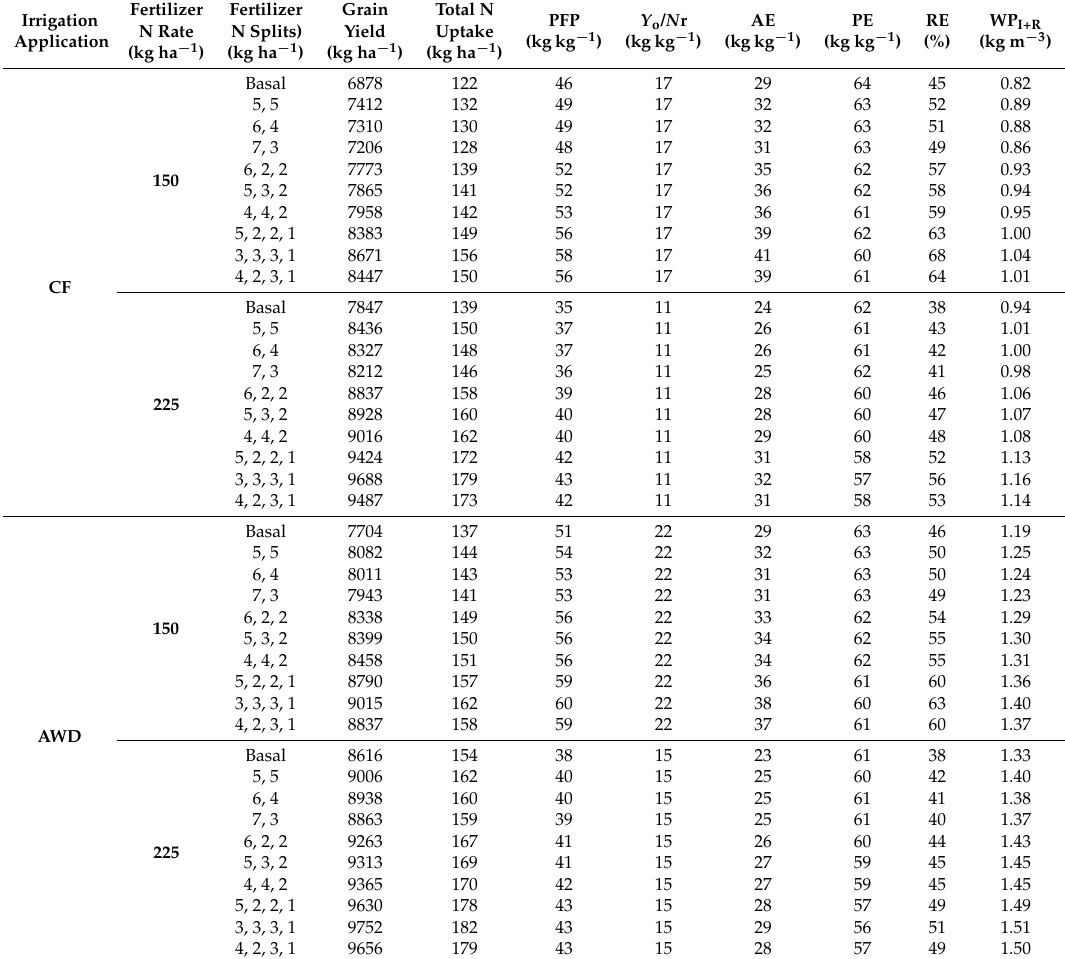
Table 2. Simulated grain yield Means, N use efficiency parameters N uptake and water productivity at different N splits, rates with AWD and CF, analyzing 45 years historic weather data from 1961 to 2005. Fertilizer Irrigation N Application